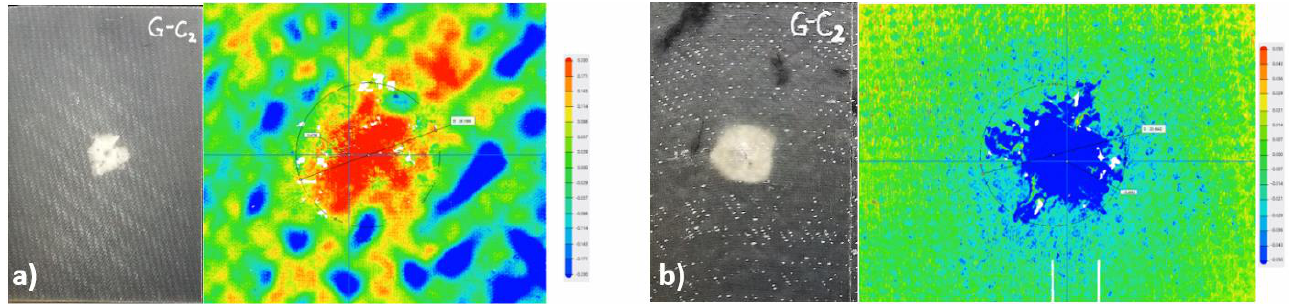
Figure 7. Damaged areas ’ front – back impacted side measured for all tested hybrid composites.